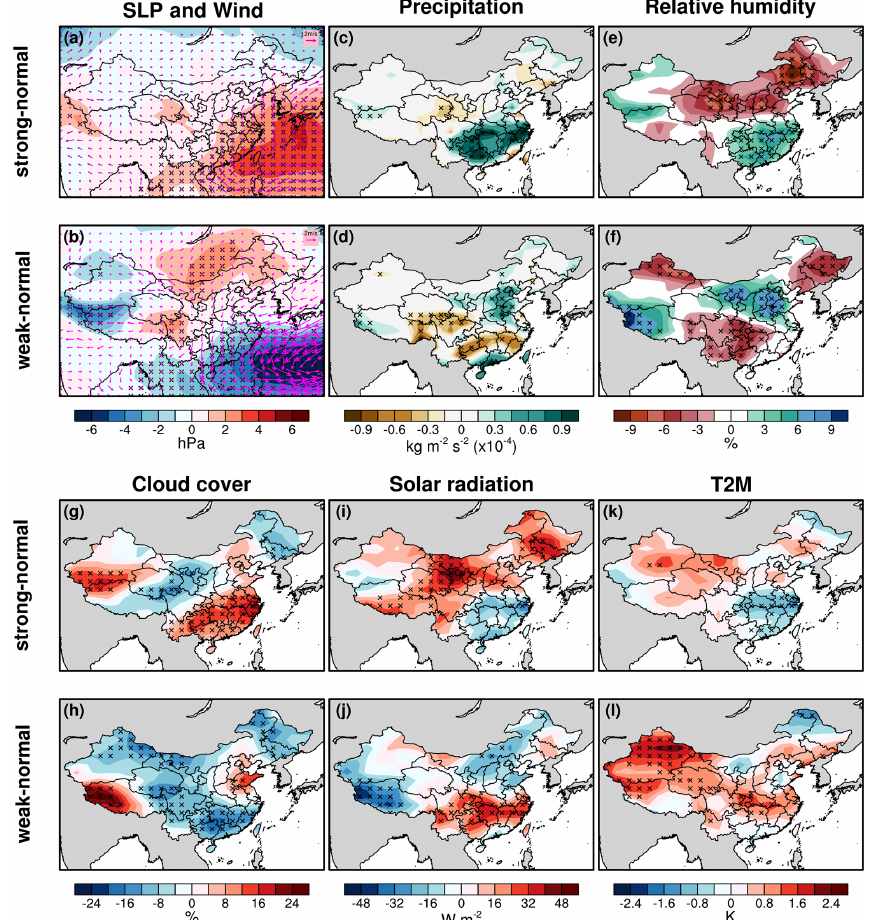
Figure 3. The difference in composite meteorological fields between different WPSH types. The first row corresponds to the difference between strong and normal WPSH days, and the second row corresponds to the difference between weak and normal WPSH days. The meteorological variables including SLP, wind, precipitation, relative humidity, cloud cover, solar radiation, and 2m temperature. The cross symbols indicate grids with significant levels less than 0.05 from Student’s t